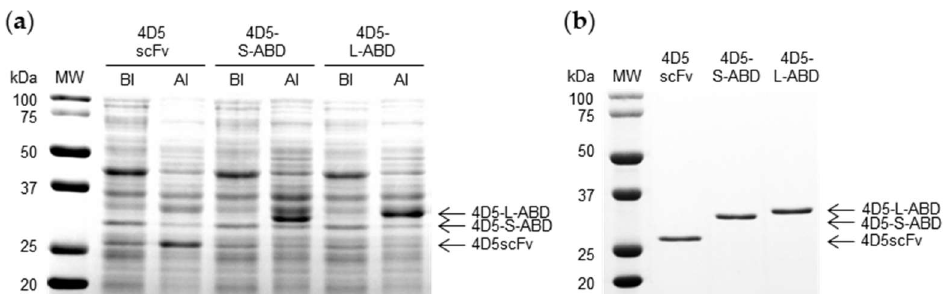
Figure 2. SDS-PAGE analysis of expression and purification of 4D5scFv and two 4D5-ABD variants. ( a ) Coomassie blue-stained SDS-PAGE gel of cell lysate samples attained during expression (MW: molecular weight standards; BI: cell lysate sample before induction; AI: cell lysate sample after induction). ( b ) Coomassie blue-stained SDS-PAGE gel of purified samples.